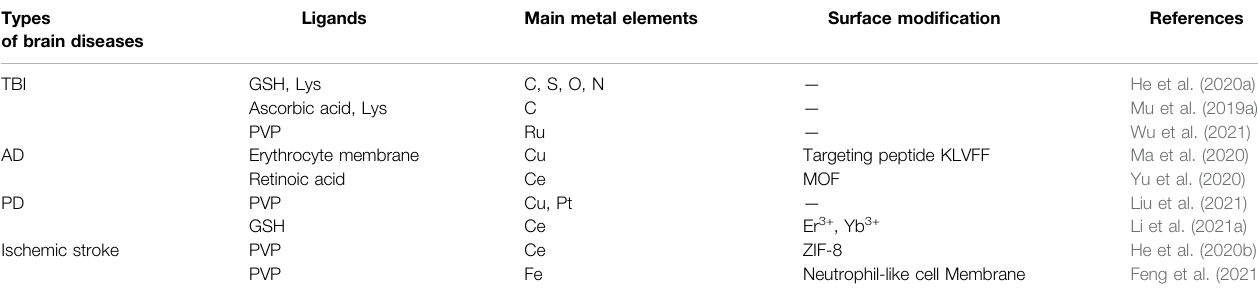
TABLE 1 | A brief summarize of the applications of nanozyme in brain